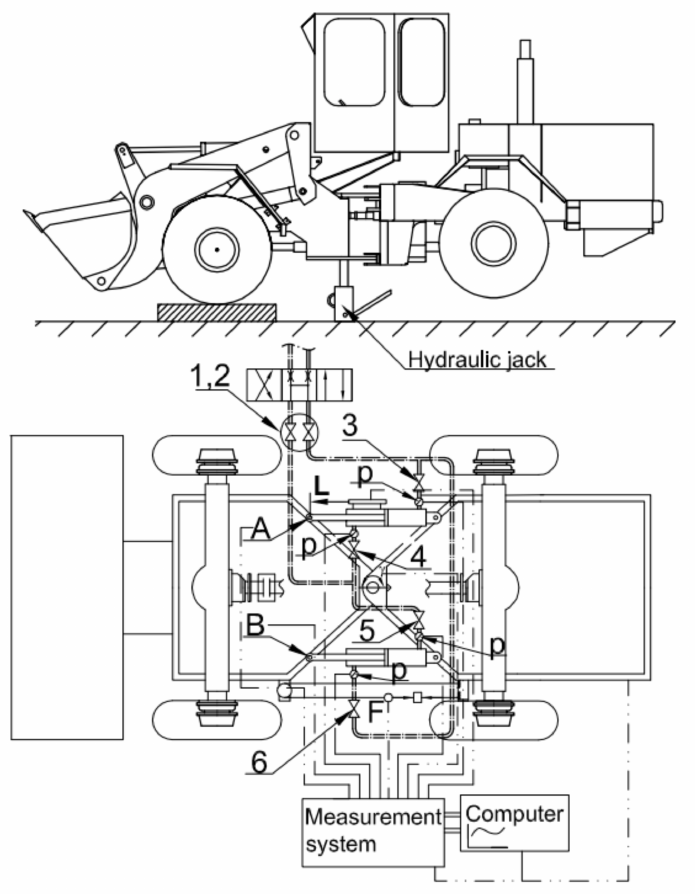
Figure 4. Articulated frame steer test machine (wheel loader Ł220) equipped with a measurement system for the identification of torsional stiffness of a steering mechanism: 1,2—cut-off valves in- stalled at the outlet and the inlet of a hydraulic line of the steering system; 3,4,5,6—cut-off valves installed at the outlet and the inlet of the steering hydraulic actuator; 7—angle sensor for measure- ment of articulation angle ∆ γ ; p —sensors to measure chambers pressure of the steering cylinders; L—transducer for measurement of the piston rod displacement of the steering actuator; A,B—force measurement in the hydraulic actuator pin; F—the device generating the steering torque ∆ M s for the machine members (frames) in the steering